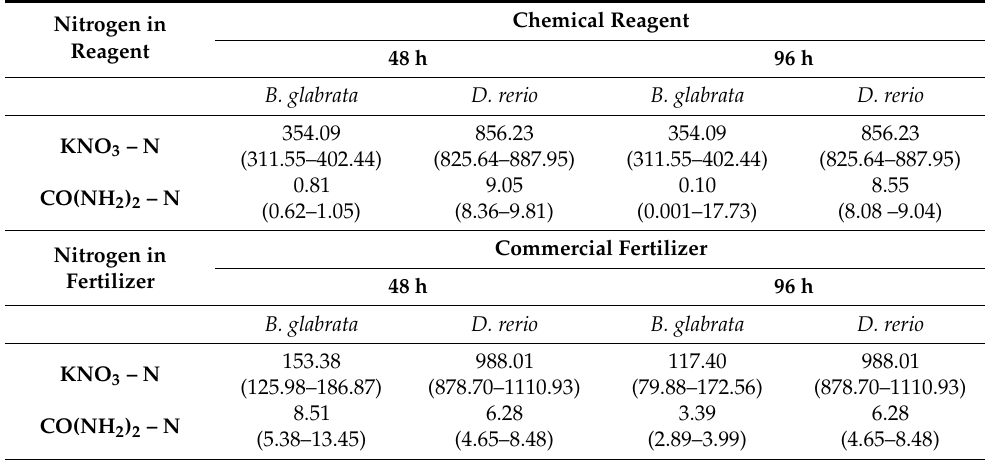
Table 4. Comparison between the lethal concentrations (LC50s) obtained in different assays with nitrogen present for the reagent and the commercial fertilizer for the B. glabrata snail and the D. rerio fish (units: mg · L − 1 ). Values in brackets represent 95% confidence